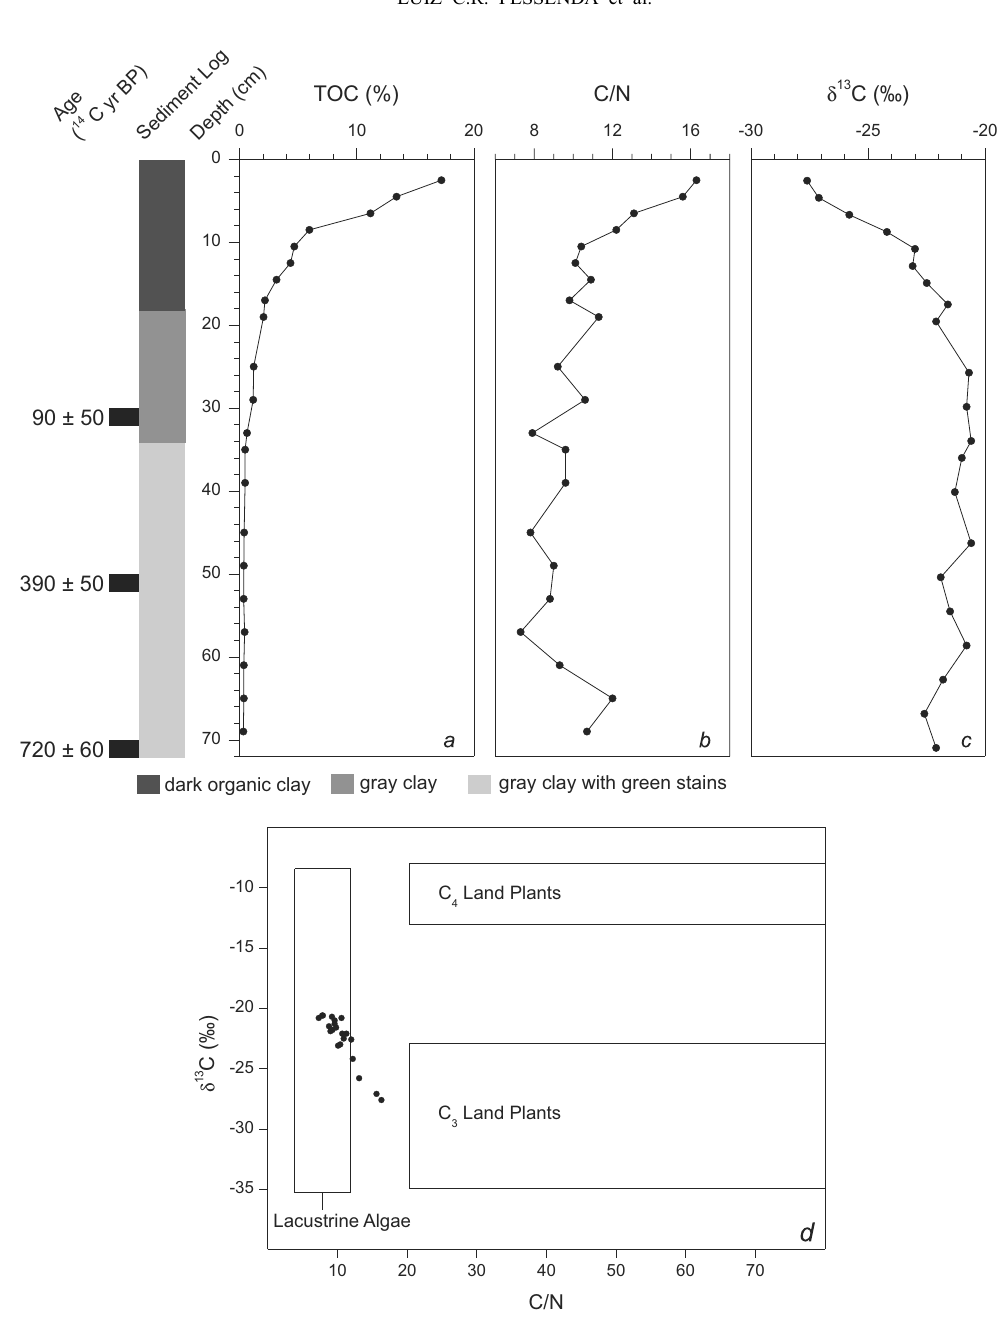
Fig. 3 – Sediment log, 14 C dating, (a) total organic carbon, (b) C/N ratio, (c) δ 13 C and (d) C/N × δ 13 C diagram (modified from Sifeddine et al. 2004) of sediment samples of Lagoa da